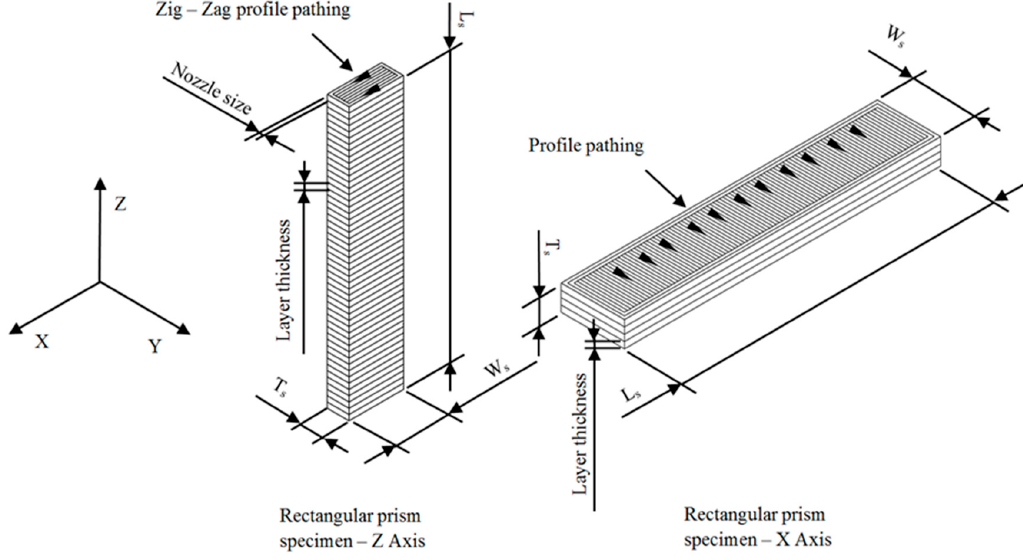
Table 4. Specimen dimensions for the characterization of GF-PA6 under compression loads.